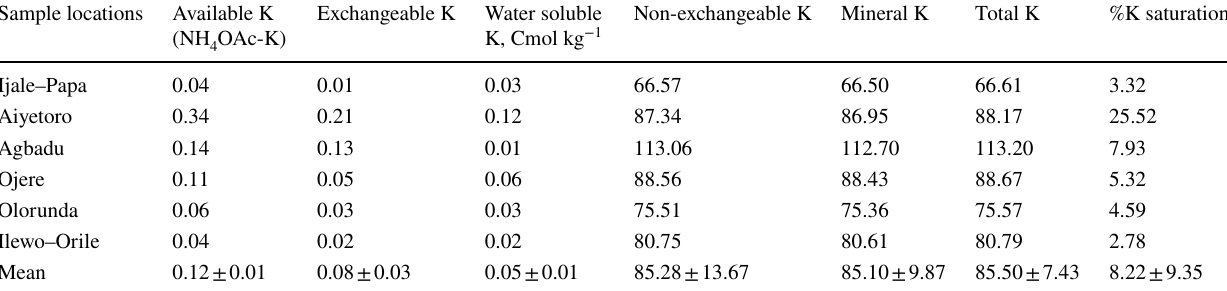
Table 2 Potassium status in studied soils Sample